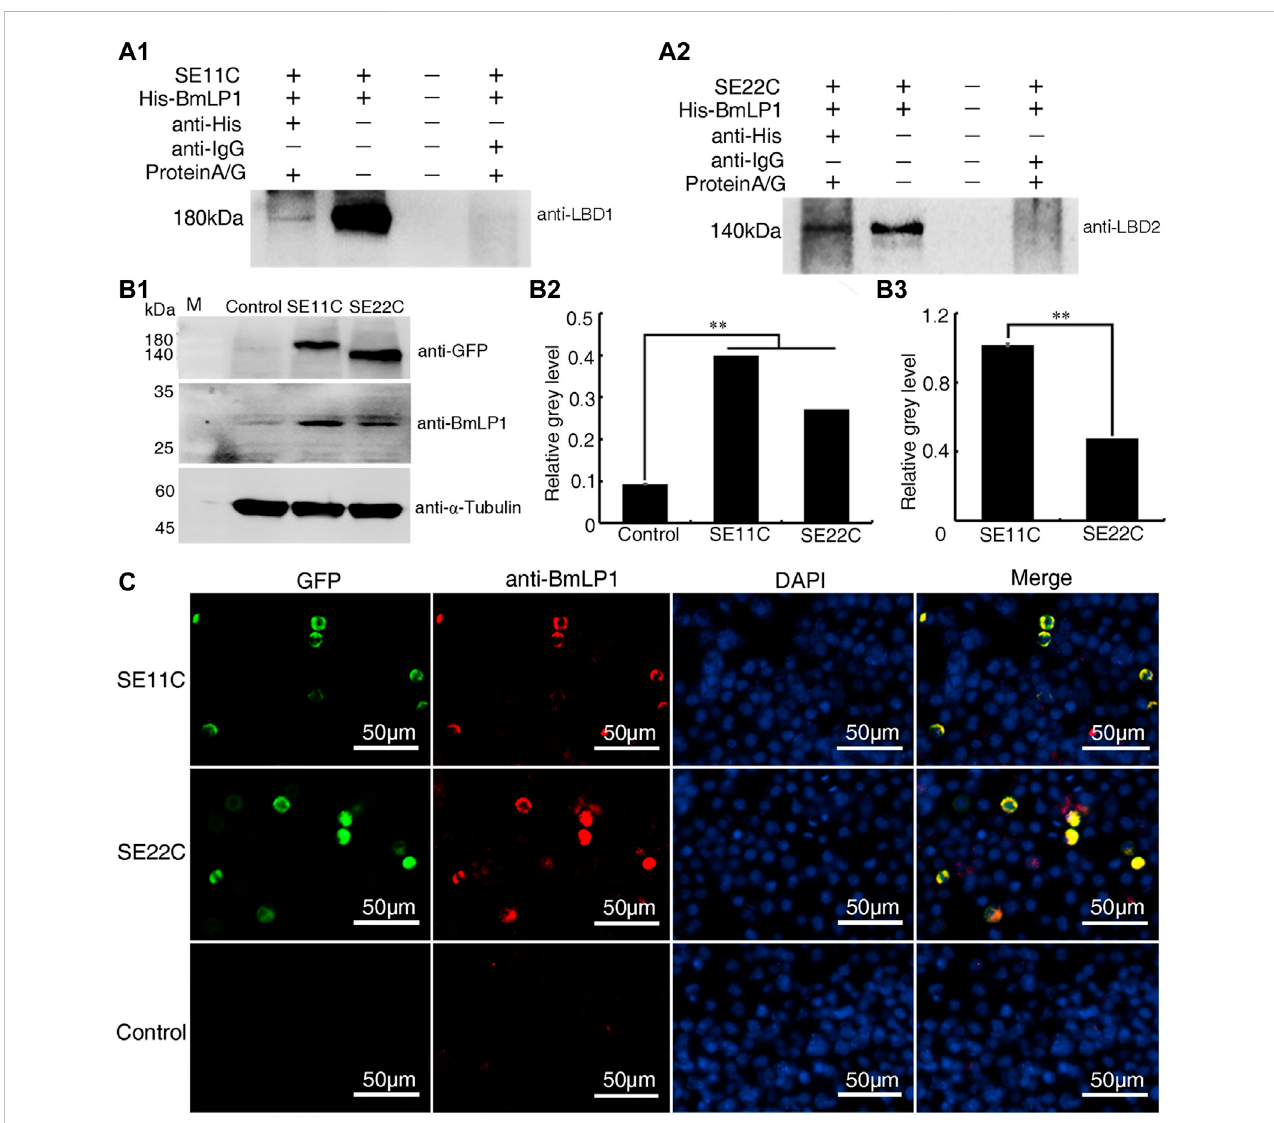
FIGURE 5 Analysis ofSE11CandSE22Cbinding with theBmLP1 invitro and mediating transportinto sf9 cells. (A) Analysis ofSE11C (A1) and SE22C(A2) bindingwith BmLP1 by Co-IP. Samples were subjected to SDS – PAGE (10% w/v polyacrylamide gels) and detected using western blotting by anti-LBD1/anti-LBD2 rabbit antibody (1:10,000), respectively, and HRP-conjugated goat anti-rabbit IgG (H + L) antibody (1:10,000). Lane1, elution from anti-His beads (sample); Lane2, inputSE11C/SE22CandHis-BmLP1proteins(positivecontrol);Lane3,lastwashingbufferforCo-IPassay(negativecontrol);Lane4,elutionfromanti-IgG beads (negative control). (B) Detection of the BmLP1 proteins transported into sf9 cells over-expressing SE11C or SE22C. (B1) Results of western blotting. Proteins were detected using anti-GFP (1:10,000), anti-BmLP1 (1:10,000) polyclonal rabbit antibody, and HRP-conjugated goat anti-rabbit IgG (H + L) antibody (1:10,000). Grayscale analysis of the protein bands in western blotting using ImageJ. α -Tubulin was used as the internal reference (B2) SE11C or SE22C protein over-expressed as an internal reference (B3). Experiments were repeated three times independently, and the relative gray level was shown as mean ± SD; **, p < 0.01. (C) Fluorescence detection of BmLP1 proteins transported into the sf9 cells by fl uorescence microscope (Life Technologies, USA). Detection used anti-BmLP1 (1:10,000) and Goat anti-Rabbit IgG (H + L) Cross-Adsorbed Secondary Antibody, Alexa Fluor ™ 594. GFP images indicate the localization of SE11C or SE22C (Green); anti-BmLP1 images indicate the localization of BmLP1 protein (Red); DAPI images are shown with nuclear counter stain (Blue); Merged images indicate a combination of GFP, anti-BmLP1, and DAPI images. Control: sf9